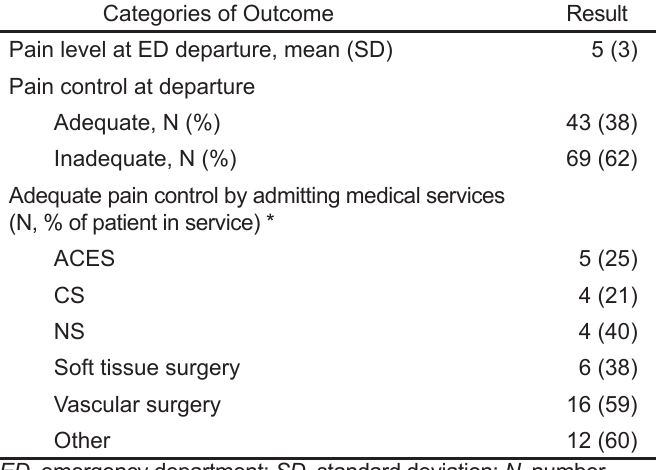
Table 2A. Outcome, defined as pain level at ED departure was greater or equal to 50% of pain level at ED